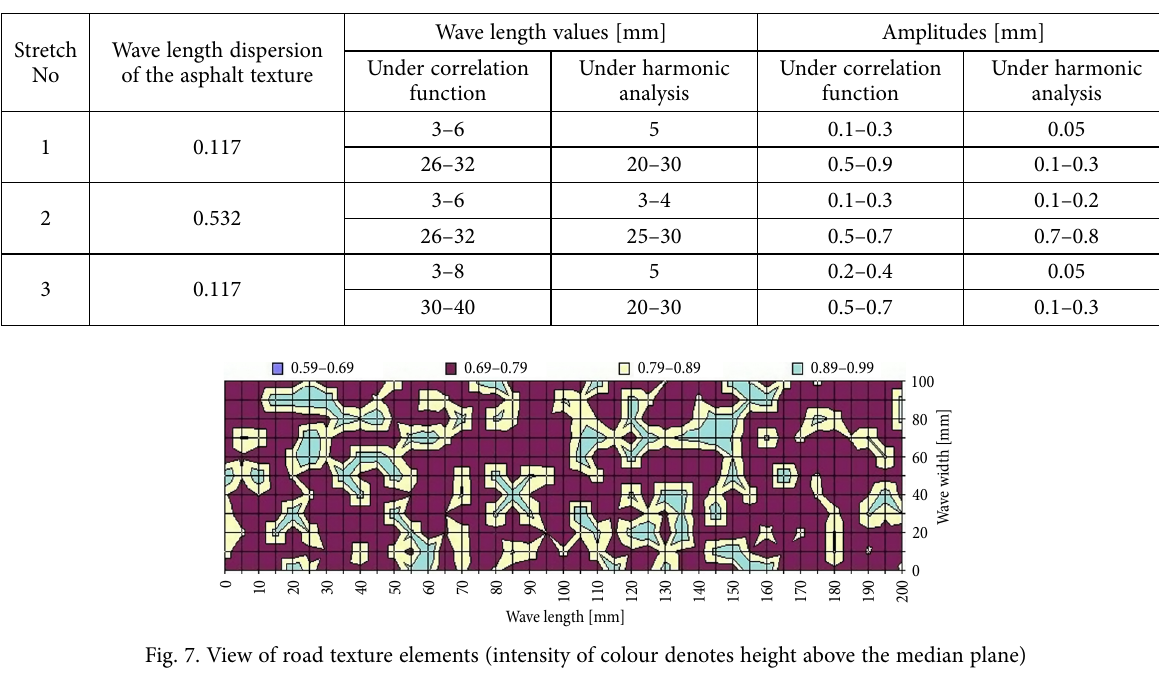
Table 2. Results of stretches analysis (the length of the analysed stretch – 0.5 m)